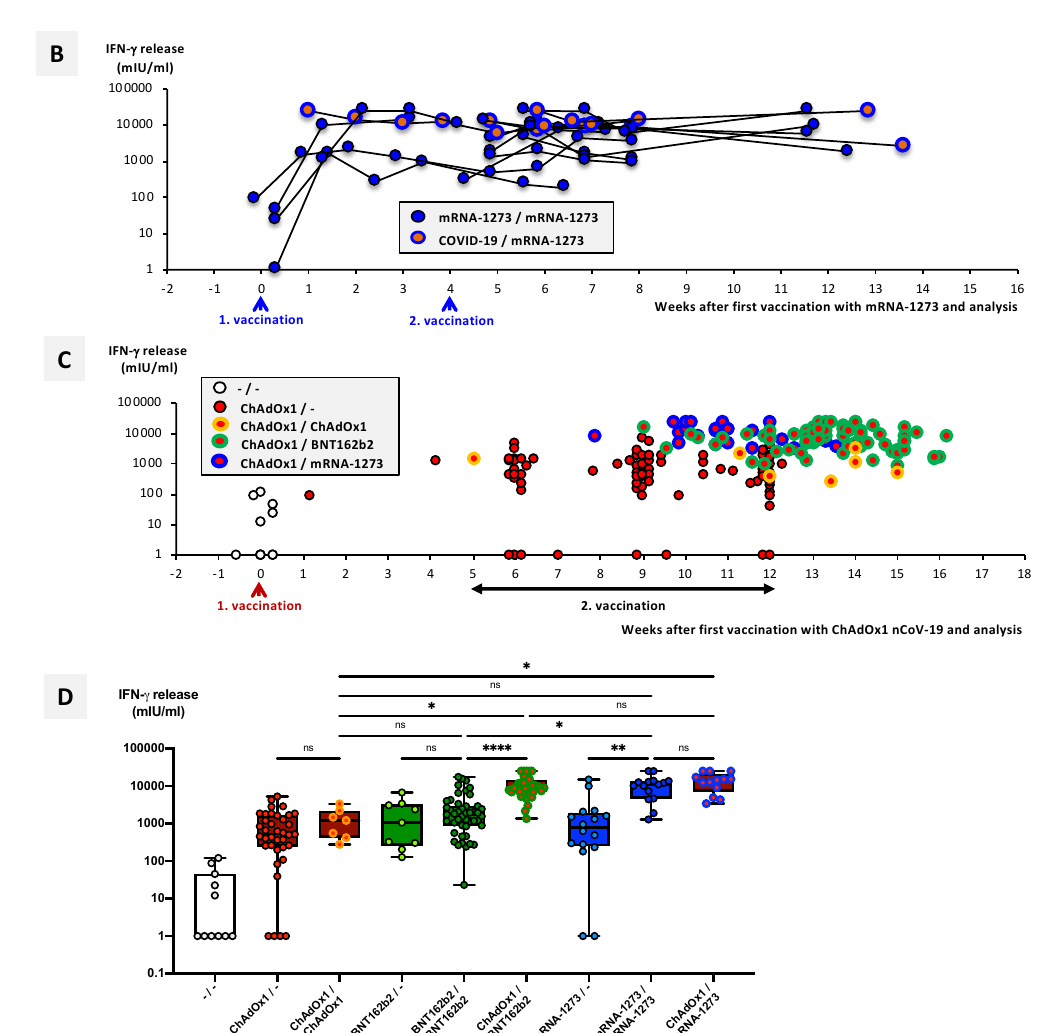
Figure 6. Comparison of SARS-CoV-2-specific T-cell response after homologous and heterologous vaccination. A total of 336 heparin blood samples from ( A ) 24 BNT162b2-vaccinated individuals, ( B ) 15 mRNA-1273-vaccinated individuals, and ( C ) 41 ChAdOx1-nCoV-19-primed vaccinated individuals were collected at different time points after their first vaccination, as indicated, and incubated overnight with a SARS-CoV-2-spike peptide mix as described in the Materials and Methods section. Then, supernatants were harvested and IFN- γ concentrations measured via ELISA. ( A – C ) Dot plots show IFN- γ concentrations at individual timepoints, as indicated. Lines connect different timepoints for corresponding individuals. Panel ( A ) also shows one case of an inverse heterologous vaccination with BNT162b2 and ChAdOx1-nCoV-19; in panel ( B ), 3 cases of COVID-19-convalescent mRNA-1273-vaccinated individuals are shown. Panel ( C ) shows results from a total of 205 timepoints from 41 individual ChAdOx1-nCoV-19-primed vaccinated individuals having continued with either homologous or heterologous vaccination regimes, as indicated by different color codes. Black lines indicate IFN- γ courses after first, and colored lines after second vaccinations. ( D ) Boxplots show peak IFN- γ concentrations 1–2 weeks after second vaccination in the various vaccination groups, as indicated. Box central horizontal lines indicate medians, box borders indicate IQR, and whiskers represent minima and maxima. Significance levels were determined by Dunn’s multiple comparisons test, with * p < 0.05, ** p < 0.005, and **** p < 0.00005. Abbreviations: IFN- γ : interferon-gamma; IQR: interquartile range; ns: not